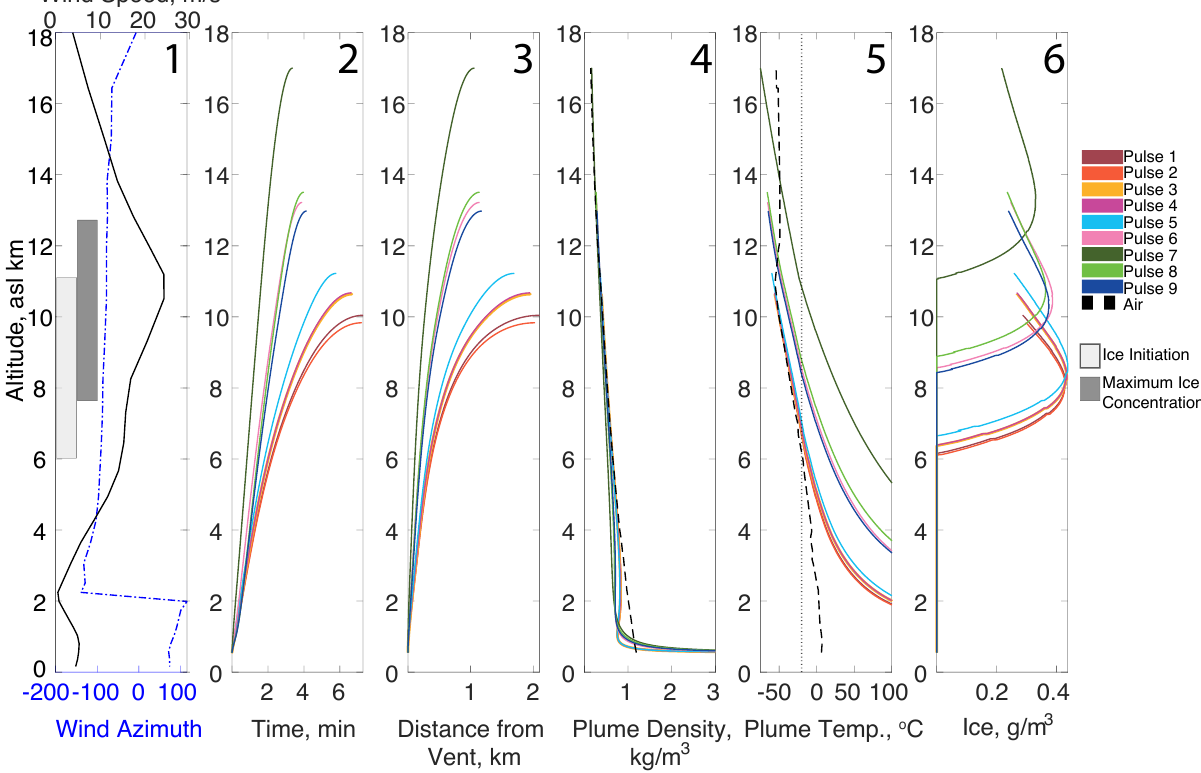
Figure 5: Atmospheric profile and results of one-dimensional volcanic plume modeling using Plumeria for the first nine of Raikoke volcano’s eruptive pulses (color indicates the eruptive pulse). [1] Atmospheric sounding measurements from Severo- Kurilsk give wind speed in m s − 1 (black line) and wind azimuth (blue dashed line) showing the direction the wind is coming from in degrees (north is zero). Plumeria model results show [2] the time required for each plume to rise to a given height; [3] the horizontal displacement of the plume centerline from the vent due to wind advection; [4] bulk plume density; [5] bulk plume temperature (grey dotted line shows − 20 °C); and [6] concentration of ice in the plume. The grey boxes in [1] indicate the full range of modeled ice initiation (6–11 km, light grey) and maximum ice concentrations (8–13 km, dark grey) within the volcanic plumes. Black dashed line in panels [4] and [5] represent the background atmosphere. Eruptive pulses 10 and 11 were not modeled as they had much lower plume heights and the eruption clouds did not reach a temperature of − 20 °C and are thus not intercomparable with the larger